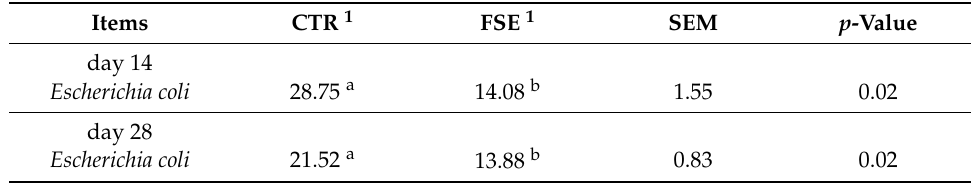
Table 4. E ff ects of Forsythia suspense extract on Escherichia coli content in feces of weaned piglets (10 8 CFUs) / g).